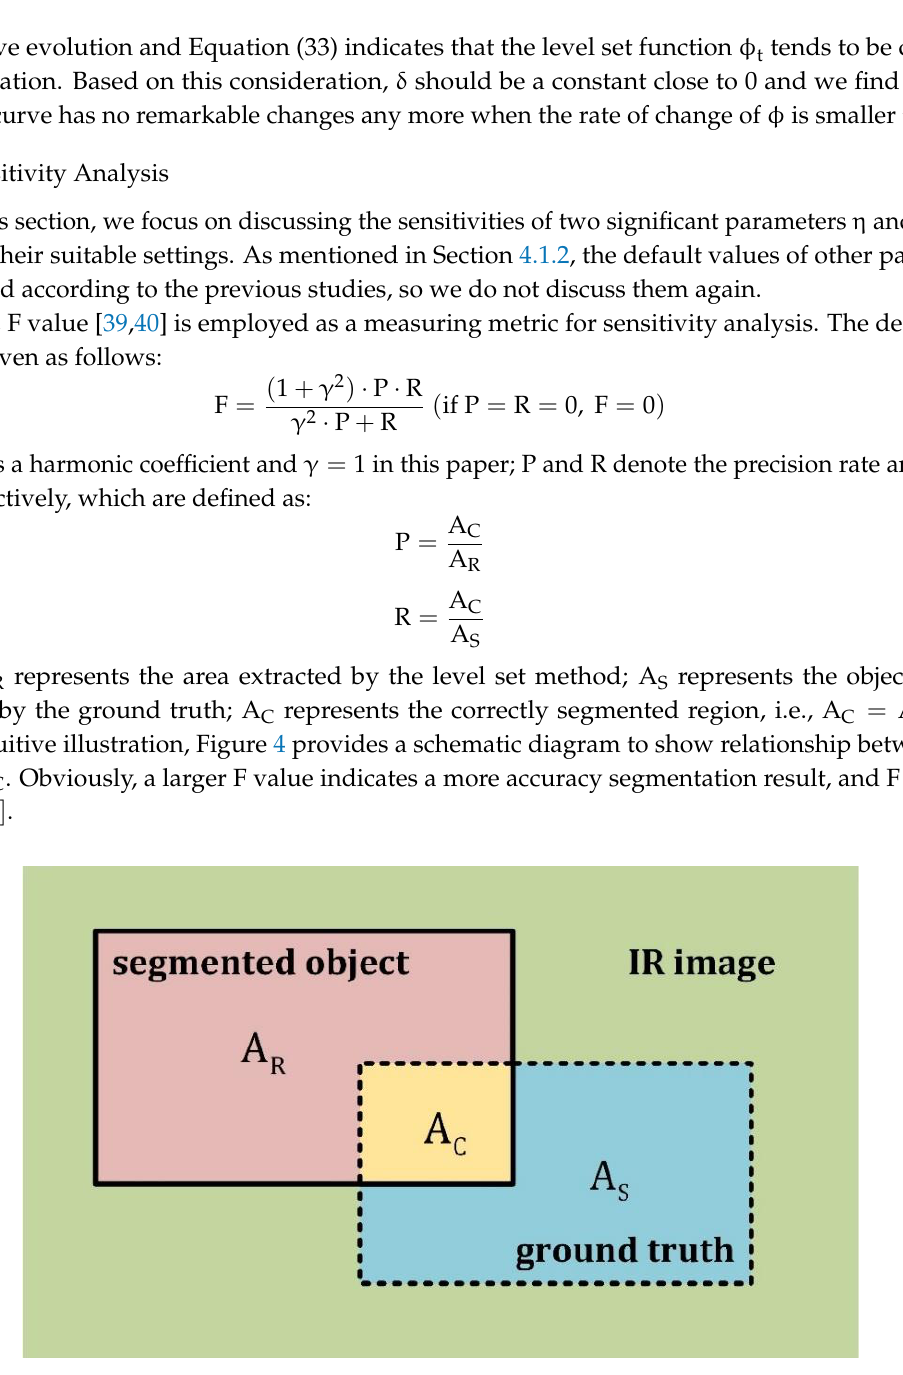
A and A , A ,where A , S R R C